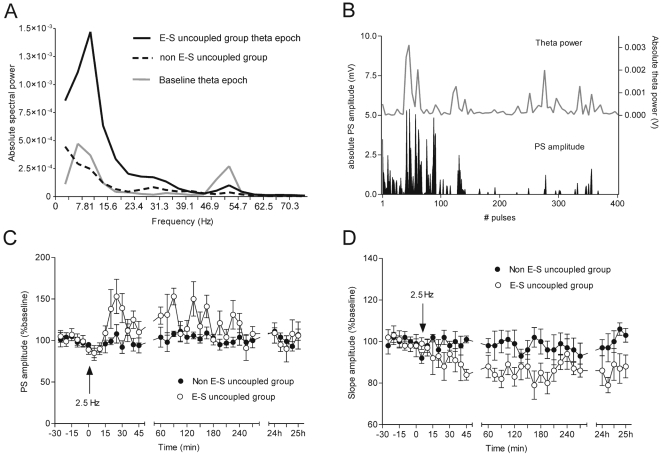
2.5 Hz stimulation-induced theta augmentation is linked to subsequent fEPSP changes.(A) A robust increase of oscillations in theta range, with a peak at 8–12 Hz, is observed in the E-S uncoupled group (n = 12) (black trace) during 2.5 Hz stimulation. The grey trace represents baseline theta (n = 6). Note the higher oscillatory power of the gamma range in the control group. The standard errors of the data are not shown for better visualisation of the graph. A significant difference (student's paired t test, p<0.01) between the E-S uncoupled group and baseline theta values, was detected in the frequencies between 8 and 15 Hz, as well as between 50 and 55 Hz. The non-E-S uncoupled group (interrupted trace) is characterized by a low spectral power (n = 6) with highest values occurring between 2 and 4 Hz. (B) Comparison of the fluctuations of PS amplitude and theta power values throughout the stimulation. This example represents a case of the E-S uncoupled group, demonstrating the absolute values of both parameters during the first 400 pulses. Note the concurrent increase of granule cell excitability and theta spectral power. (C) Population spike amplitude in the cases with no generalized response to 2.5 Hz (900 pulse) can be subdivided into a group that displayed increased PS amplitude (white circles, n = 6) and a group that displayed no significant changes (filled circles, n = 6). (D) Field EPSP slope measurements of the same animals reveal behaviour that is opposite to the PS response. Compared to the baseline period, the fEPSP, in the affected cases, developed a long-term decrease (E-S uncoupling).